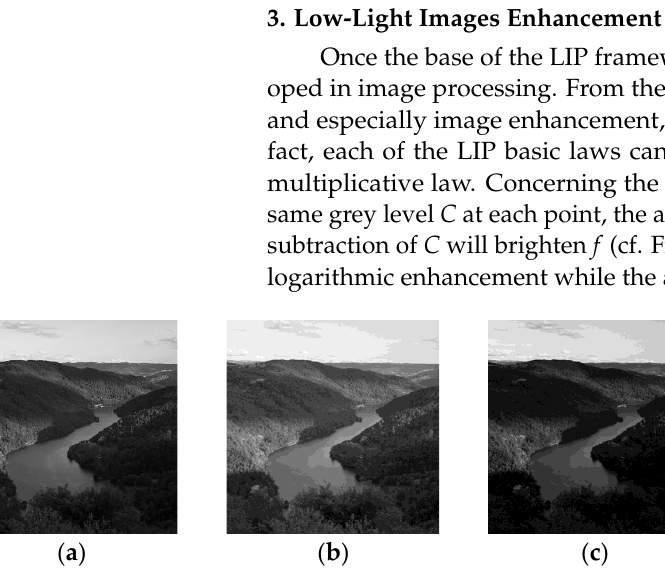
Figure 1. Brightening/darkening an image thanks to LIP laws. ( a ) Original image f ; ( b ) Image 0.75 ⨻ f ; ( c ) Image 1.25 ⨻ f ; ( d ) Image f ⨺ 100; ( e ) Image f ⨹ 100.